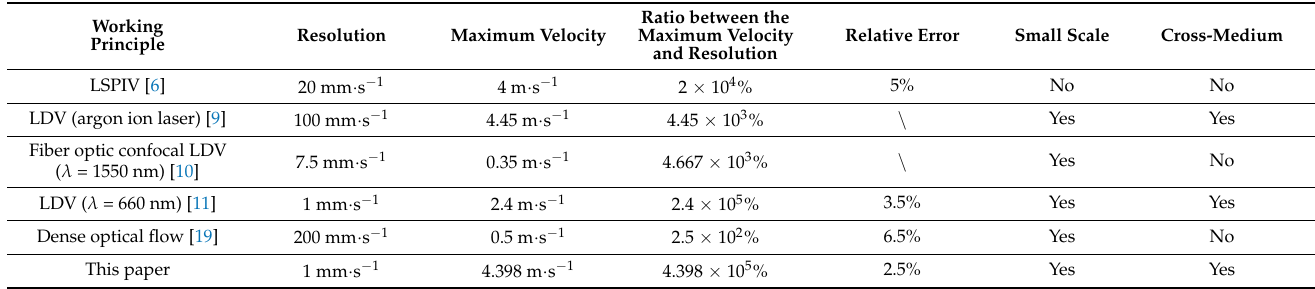
Table 1. Performance Comparison of Various